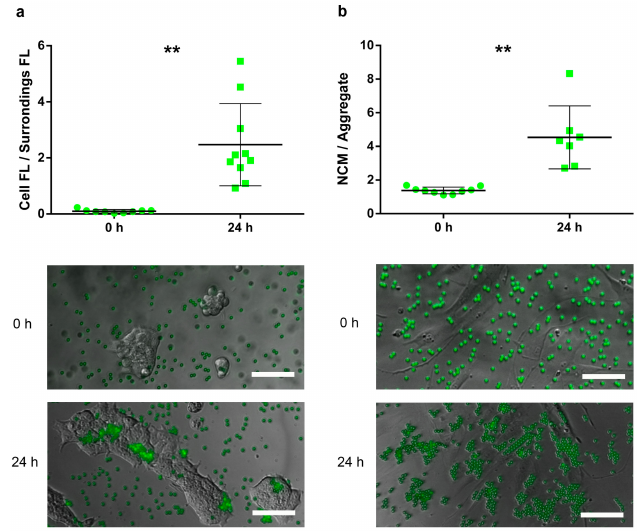
Figure 1. Attachment assay using fluoresbrite yellow-green negatively charged microspheres (FYG-NCMs) in HaCaT and HDFa. ( a ) Ratio between the fluorescence intensity within cell area and immediate surroundings assessed in the HaCaT cell line; FYG-NCMs suspended in dd H 2 O and incubated for 0 and 24 h; ( b ) Particle aggregation factor measured in human fibroblasts; FYG-NCMs suspended in dd H 2 O and incubated for 0 and 24 h; ( a–b ) Representative epi-fluorescence images of cells assayed with FYG-NCMs (green). **, p < 0.01. Scale bars, 100 µ m. FL,